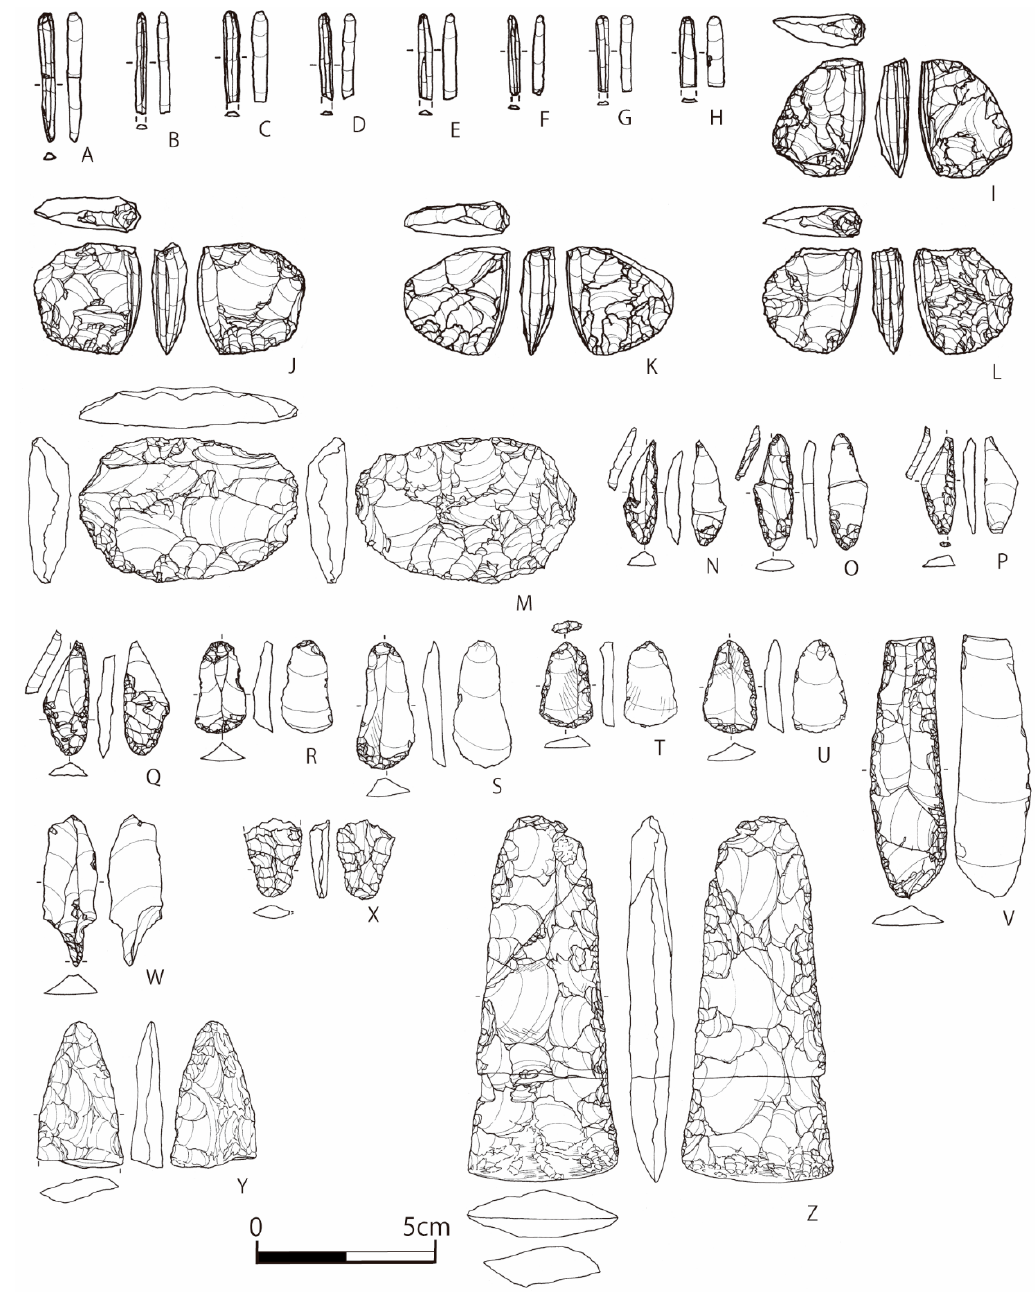
Figure 3. Stone artefacts in the Oshorroko techno-complex. Examples from the Oribe-17 site in eastern Hokkaido: ( A–H ) microblades; ( I–L ) Oshorroko-type microblade cores; ( M ) bifacial blank; ( N–Q ) burins; ( R–U ) end-scrapers; ( V ) side-scraper; ( W ) drill; ( X ) broken bifacial stemmed point; ( Y ) broken bifacial point; ( Z ) edge-ground stone axe. Reproduced from [58].